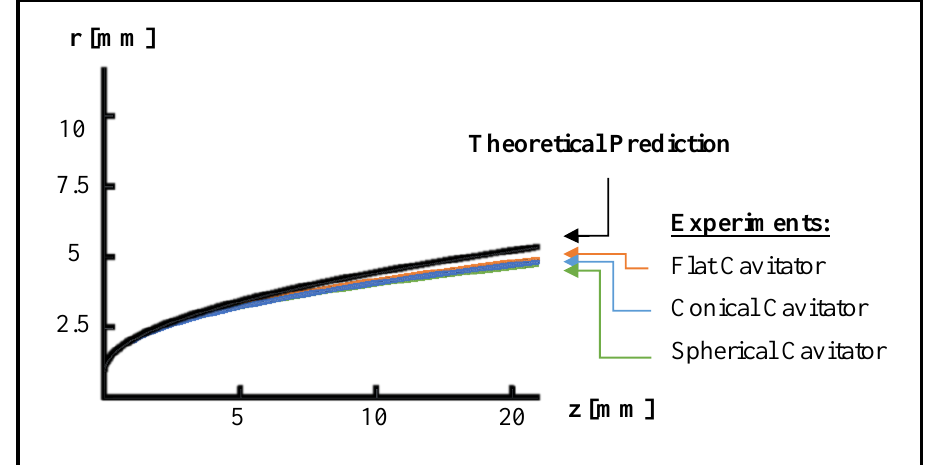
Figure 10. Comparison between the theoretical prediction and experimental results of the bubble geometry for the three cavitators.